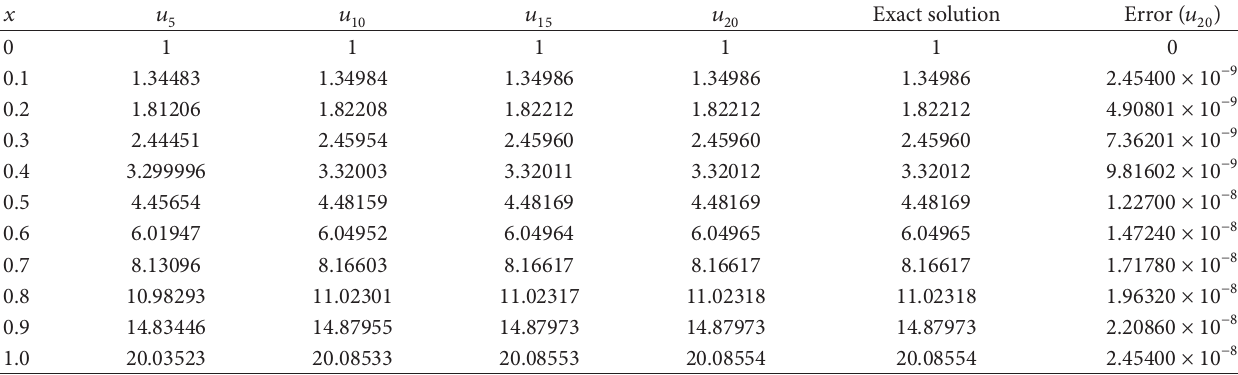
Table 3: Numerical result of Example 3.